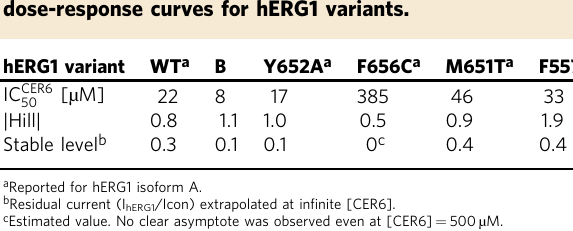
Table 1 Values of IC 50 and Hill coef fi cients calculated from dose-response curves for hERG1